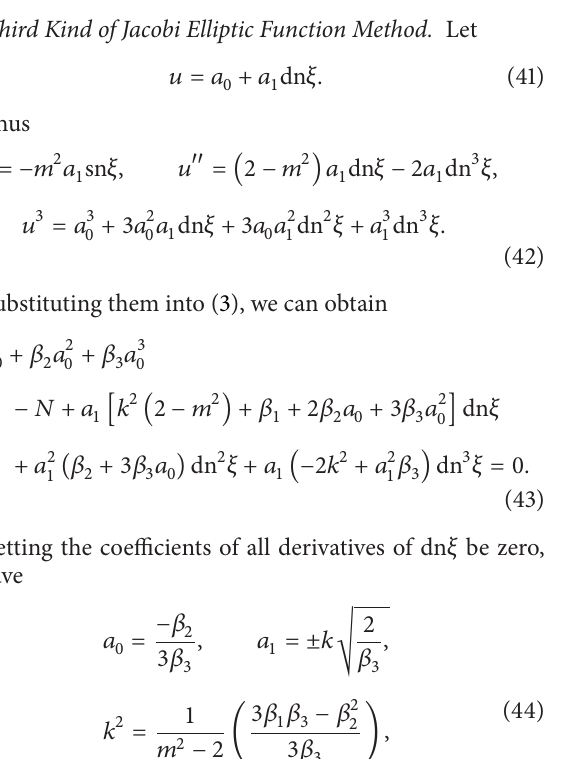
Taking 𝑚 → 1 , cn 𝜉 → sech 𝜉 , (38) can be rewritten as